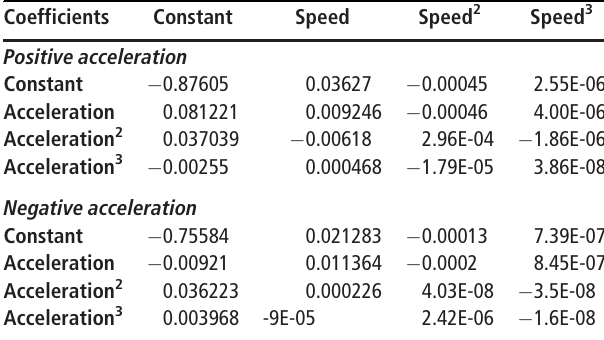
Table IV Coef fi cients of VT-micro model